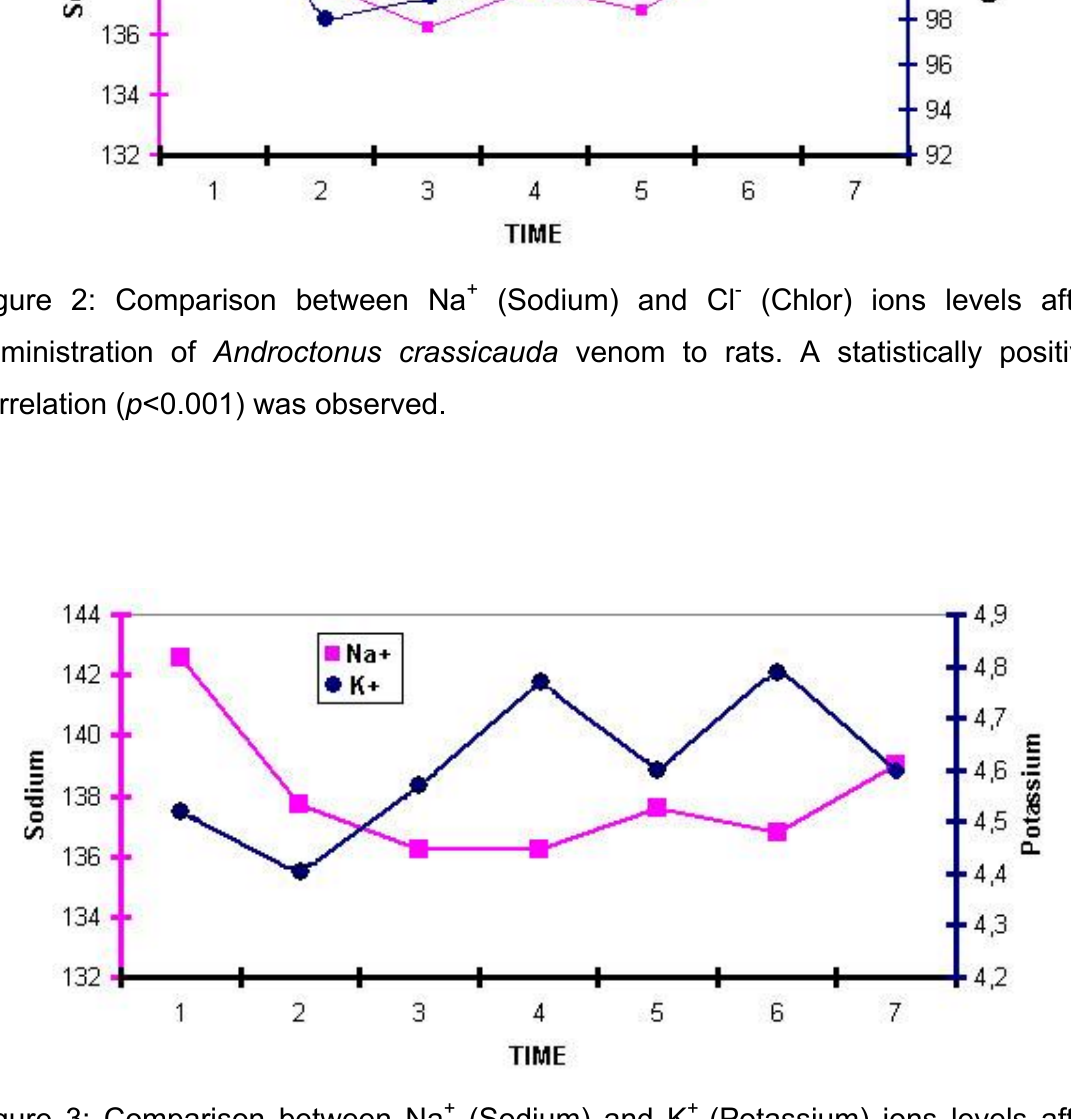
Figure 3: Comparison between Na + (Sodium) and K + (Potassium) ions levels after administration of Androctonus crassicauda venom to rats. A statistically negative correlation ( p <0.05) was